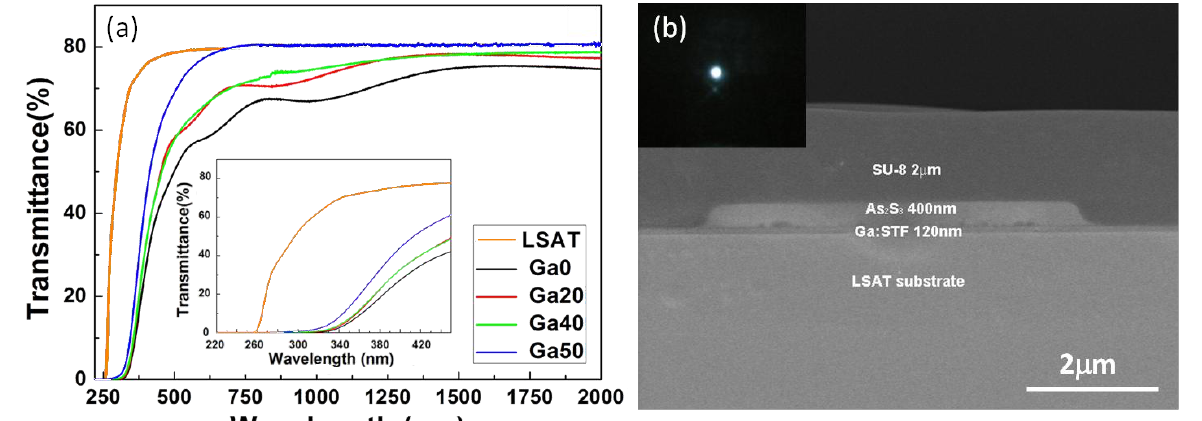
Figure 5. ( a ) Optical transmittance spectra of Ga:STF films with the inset showing a close-up view of the optical band gap region; ( b ) Cross-sectional SEM image of an As S /Ga:STF strip-loaded waveguide with an SU-8 top-cladding layer fabricated on an 2 3 LSAT(001) substrate. The inset shows the guided mode profile at 1550 nm wavelength [99]. (Reprinted with permission from [99]. Copyright 2011 AIP Publishing